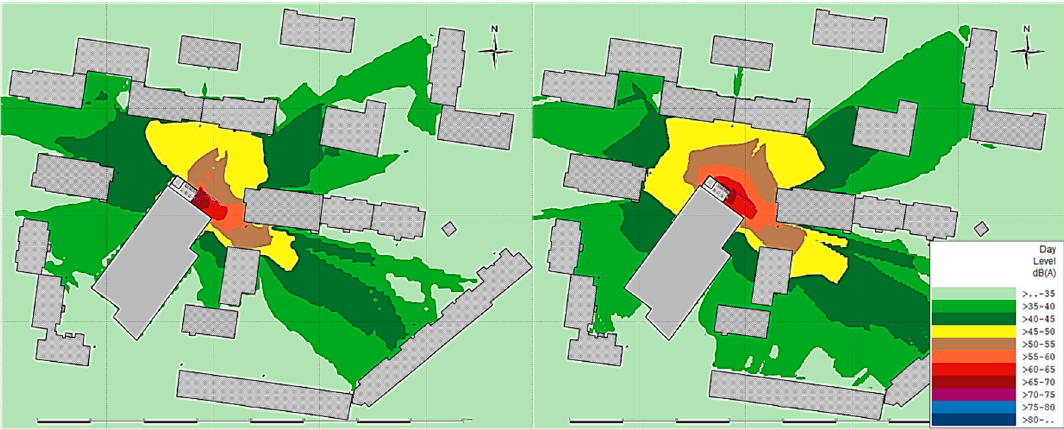
Figure 7. Scenario 3 with a sloped acoustic barrier and higher height—Lday with all noise sources ( left : 4 m, right : 10 m).